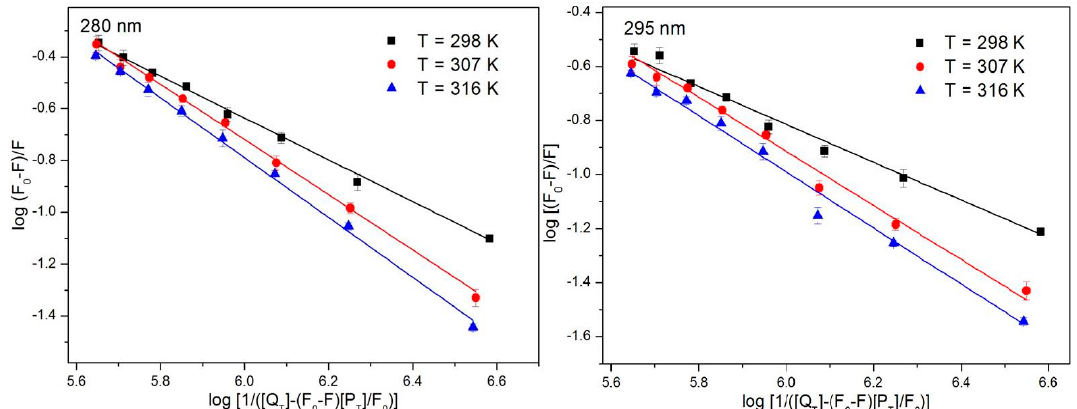
Figure 4. The log( F 0 − F )/ F against log[1/([ Q T ] − ( F 0 − F )[ P T ]/ F 0 )] plots of ATR-HSA system at 298 K, Figure 4. The log ( F 0 − F )/ F against log [1/([ Q T ] − ( F 0 − F )[ P T ]/ F 0 )] plots of ATR ‐ HSA system at 298 K, 307 307 K and 316 K ( n = 3). K and 316 K ( n = 3).